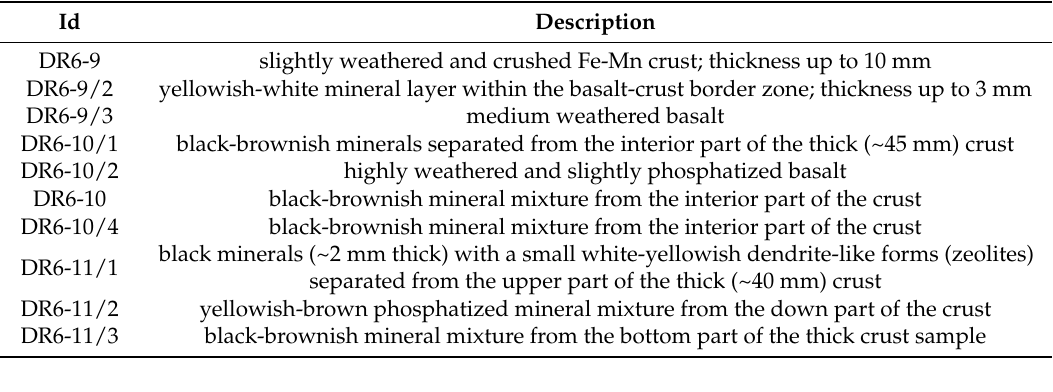
Table 1. General description of the DHR samples.